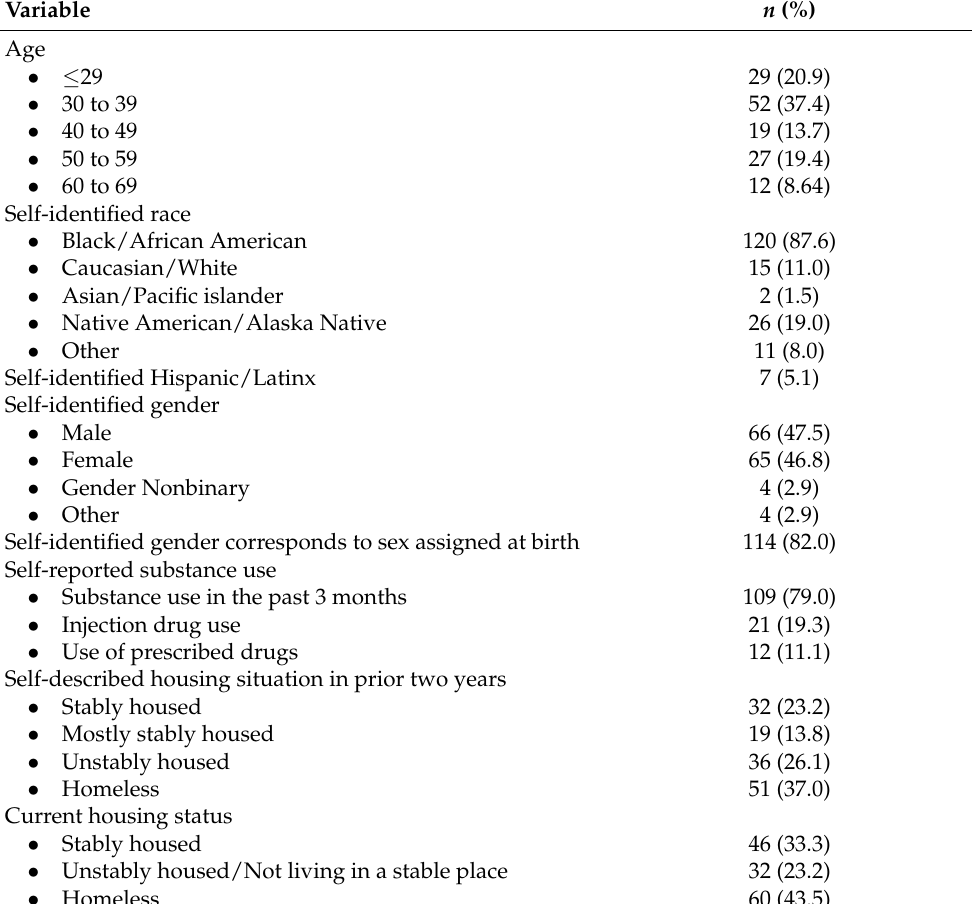
Table 1. Sample demographics ( n =